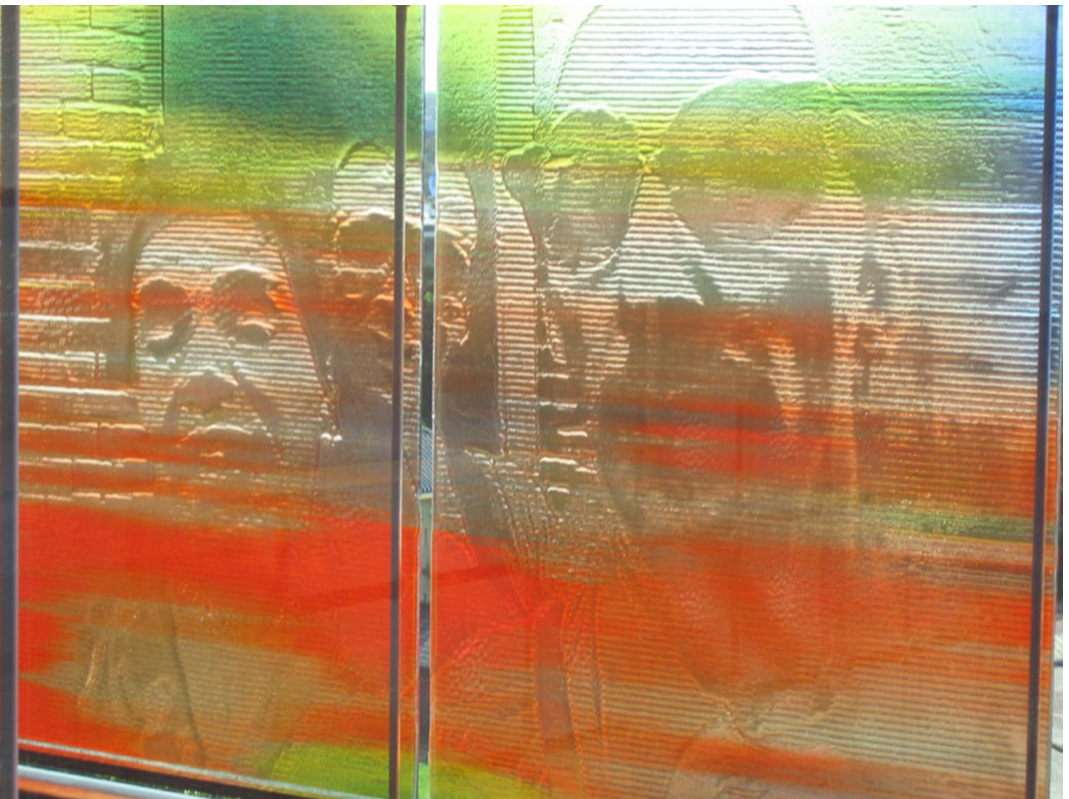
Fig. 2 Beeld en Geluid’, detail. Photography scagliolabrakkee © Neutelings Riedijk